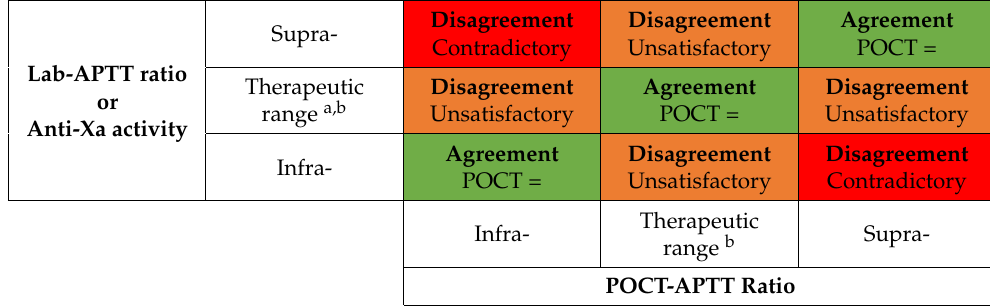
Table 2. POCT-APTT ratio relationships with Lab-APTT ratio or anti-Xa activity.